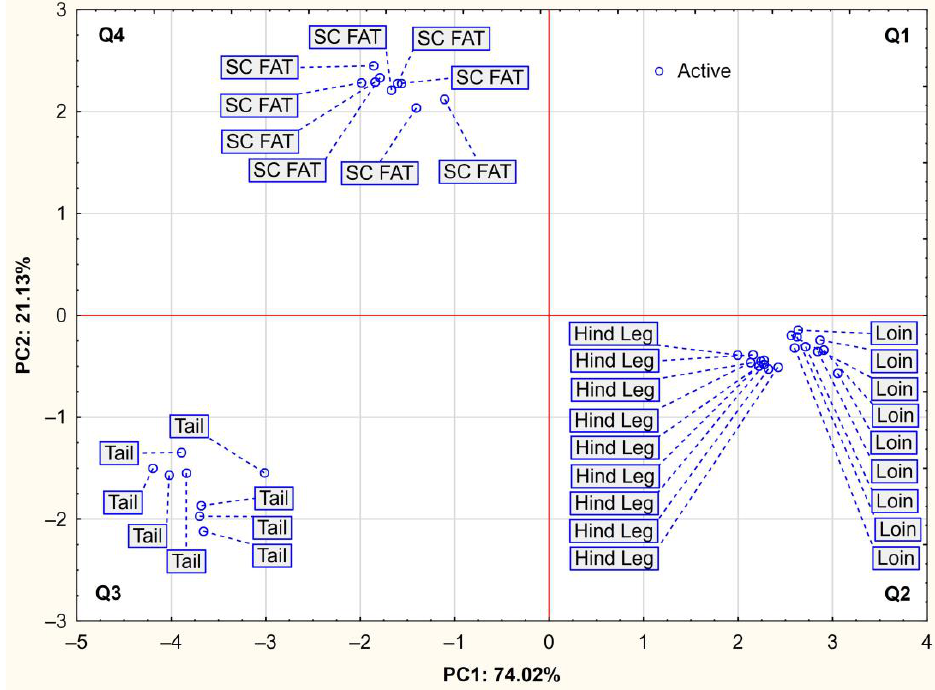
Figure 2. Projection of cases depending on type of beaver tissue in the a two-factor plane (PC1 × PC2); SC Fat, subcutaneous fat; Loin: Longissimus lumborum and Longissimus thoracis ; Hind Leg: Semimembranosus , Biceps femoris and Semitendinosus .